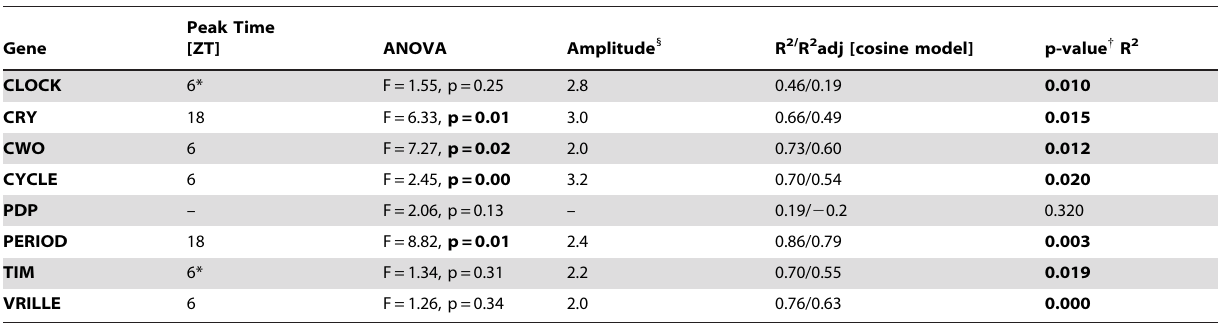
Table 1. Summary of gene expression